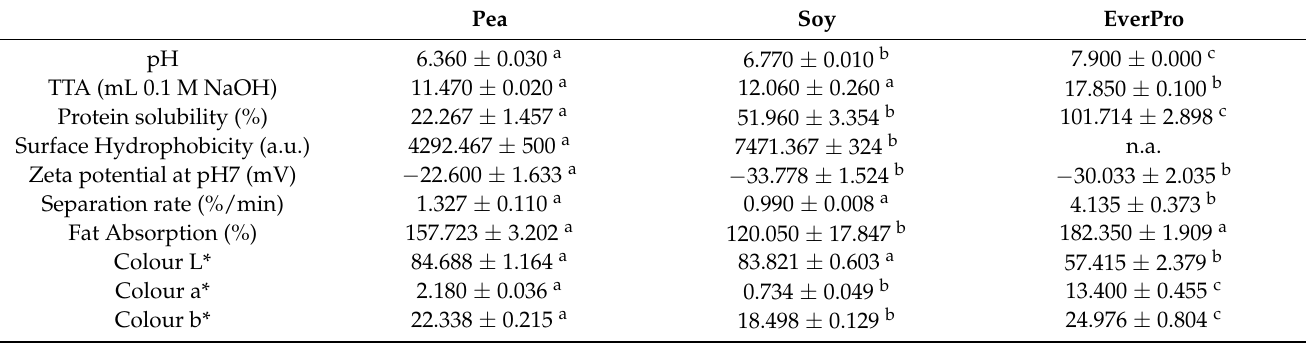
Table 3. Functional properties of pea, soy and EverPro. Values in the same row that share a letter do not differ significantly. Pea